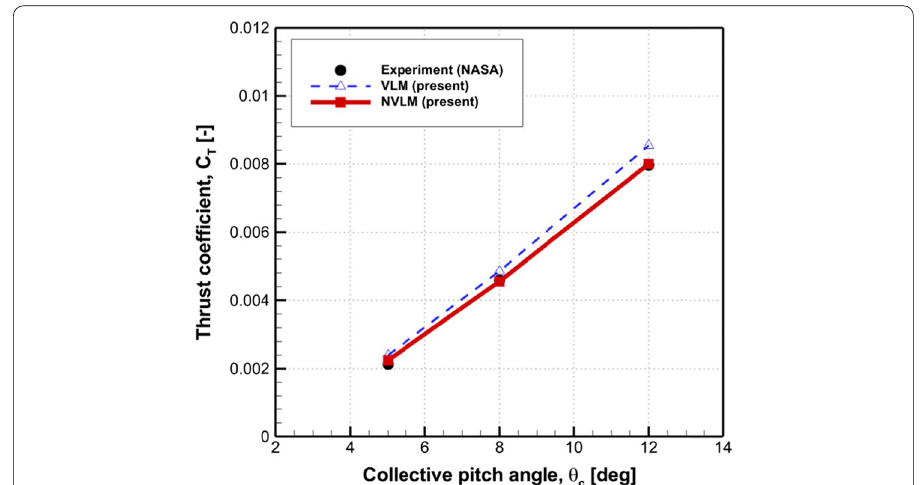
Fig. 6 Comparison of integrated rotor thrust coefficient depending on collective pitch angle